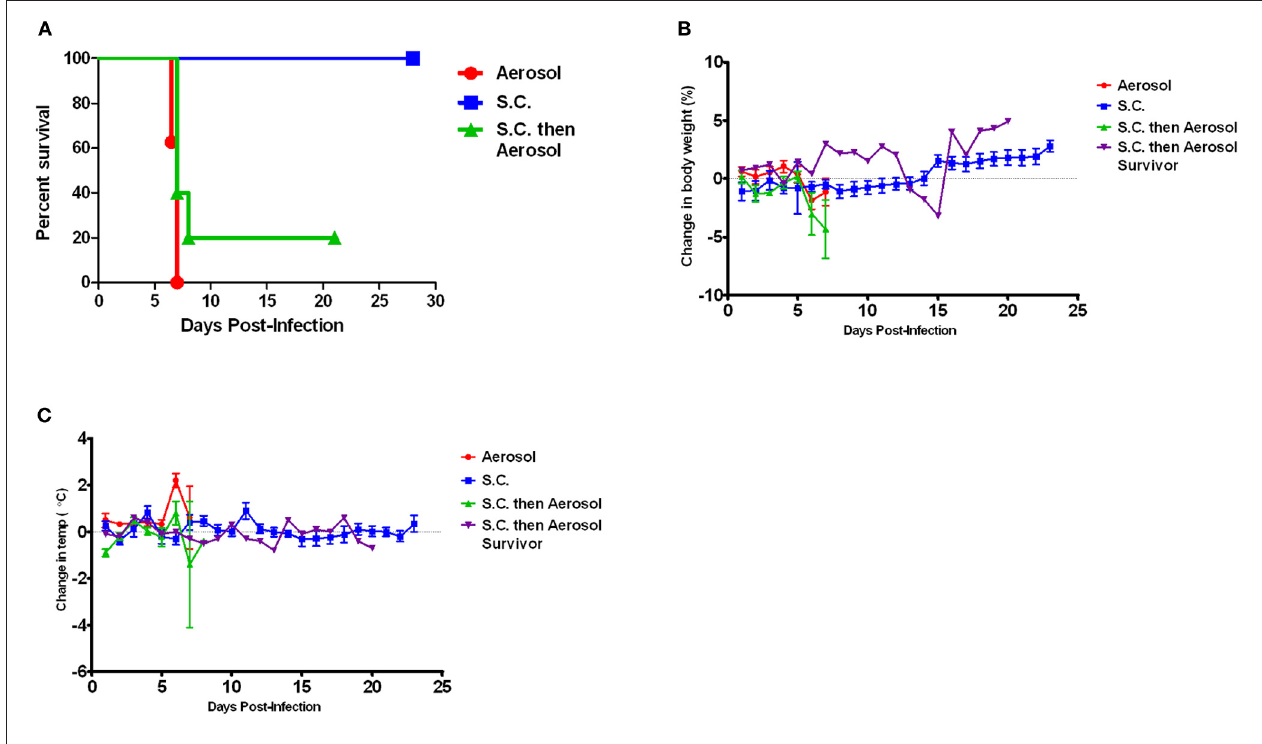
FIGURE 10 | Effect of infection route on survival of Lewis rats. (A) Shows survival of Lewis rats after either subcutaneous (blue line; n = 5) or aerosol exposure (red line; n = 6). The rats that survived s.c. exposure were re-exposed to RVFV by aerosol infection 28 days after the